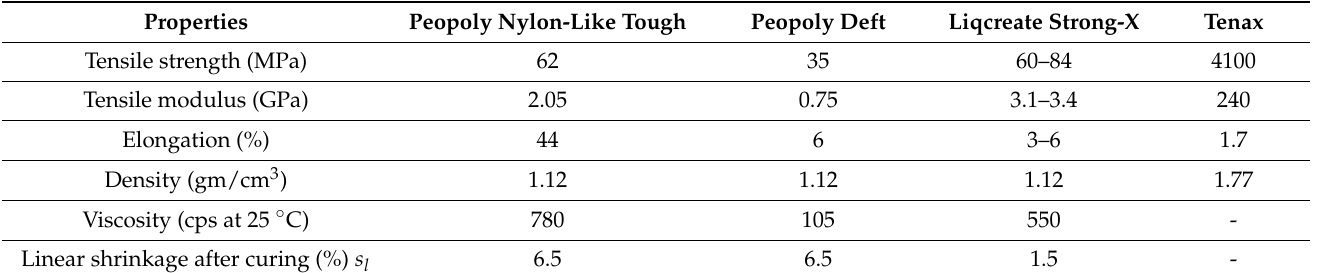
Table 1. Mechanical properties of composite components